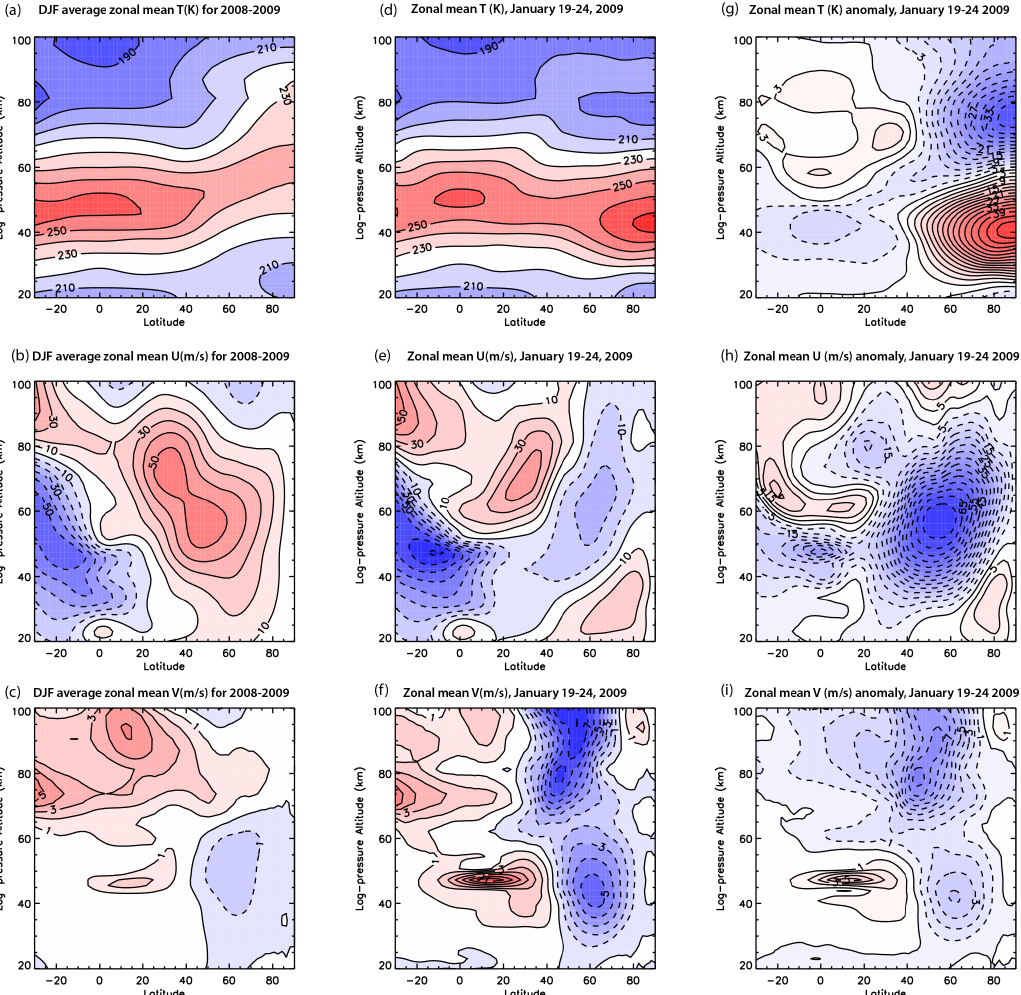
Figure 5. The seasonal average zonal-mean (a) temperature ( T ), (b) zonal wind ( U ) and (c) meridional wind ( V ) between December and February during the winter of 2008–2009, the zonal-mean (d) temperature (e) zonal wind and (f) meridional wind during 19–24 January days centered around 2009 SSW event and the zonal-mean anomalies as difference from climatological mean during the SSW event in (g) temperature (h) zonal wind and (i) meridional